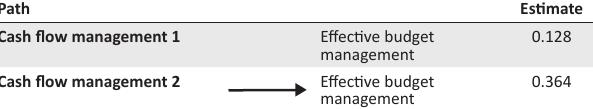
TABLE 16: Cash flow management (Hypothesis